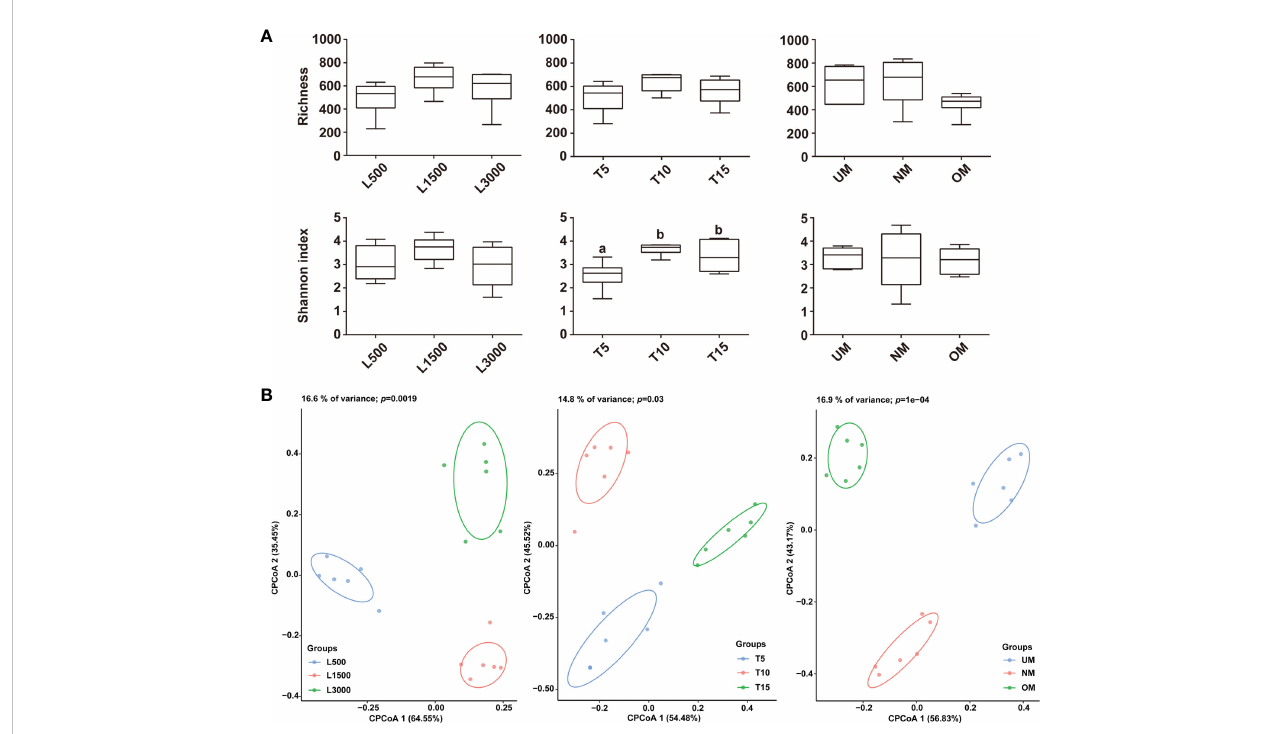
FIGURE 3 Comparisons of a (A) and b (B) diversities among the epiphytic bacterial communities associated with different treatment groups. The a -diversity was estimated using Observed species and Shannon index, and letters on the boxes indicate signi fi cant difference ( p < 0.05, ANOVA, Tukey post-hoc test) among groups. Plots for the b -diversity were performed based on the Bray – Curtis